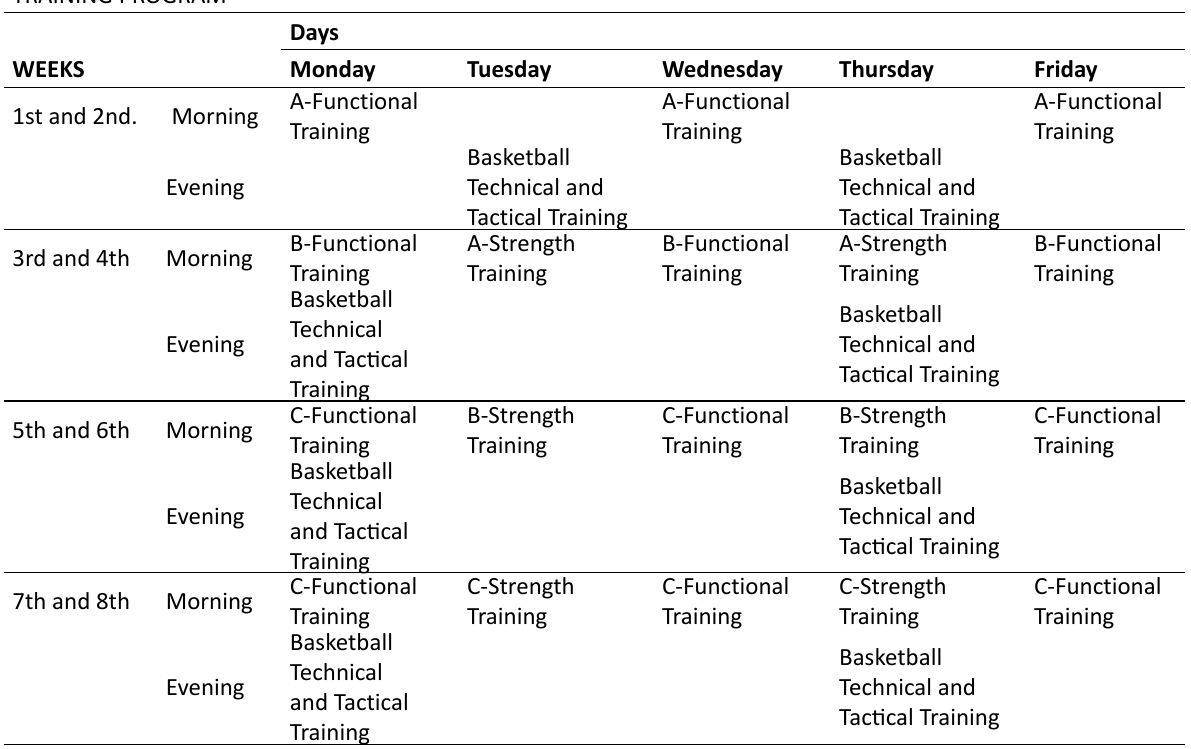
Table 3. 8 weeks Training